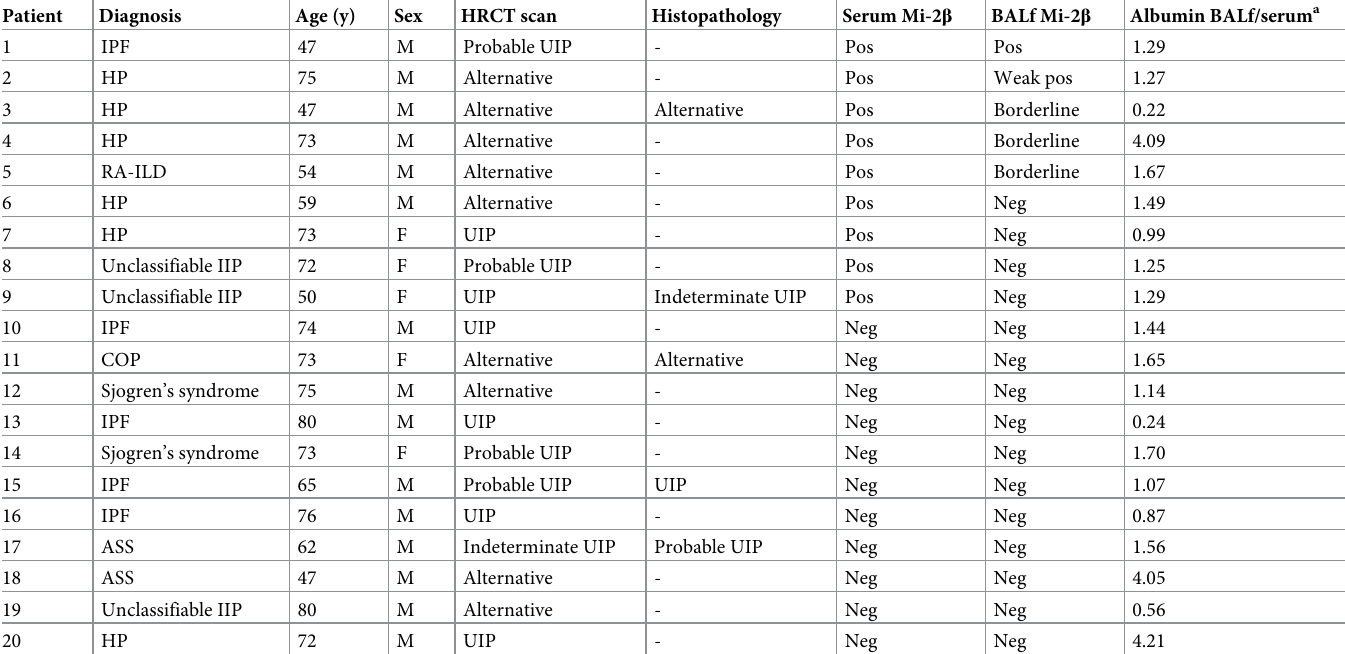
Table 5. Mi-2 β measurement in bronchoalveolar lavage fluid in ILD